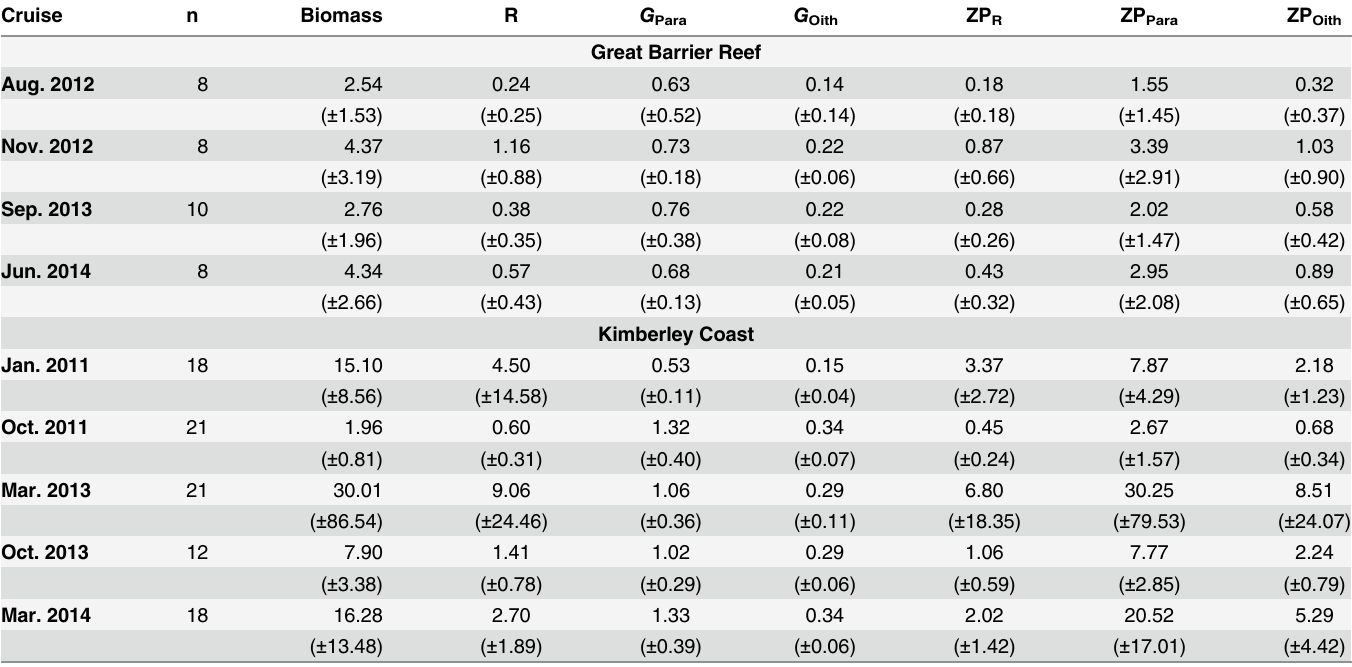
Table 3. Summary of biomass (mg C m -3 ), respiration (R, mg C m -3 d -1 ), growth ( G d -1 ) and zooplankton production (ZP, mg C m -3 d -1 ) estimates for each cruise based on the > 150 μ m size fraction. Growth has been calculated according to the empirically derived relationships between spAARS activities and independently estimated G for Paracartia grani (Eq 4) and for Oithona davisae (Eq 5). The subscripts Para and Oith refer to calculations made on each of these bases, respectively. ZP has been calculated 3 ways for comparison; on the basis of R (Eq 3), and on the basis of each estimate of G . The numbers are means and standard deviations of each set of n estimates for each cruise.